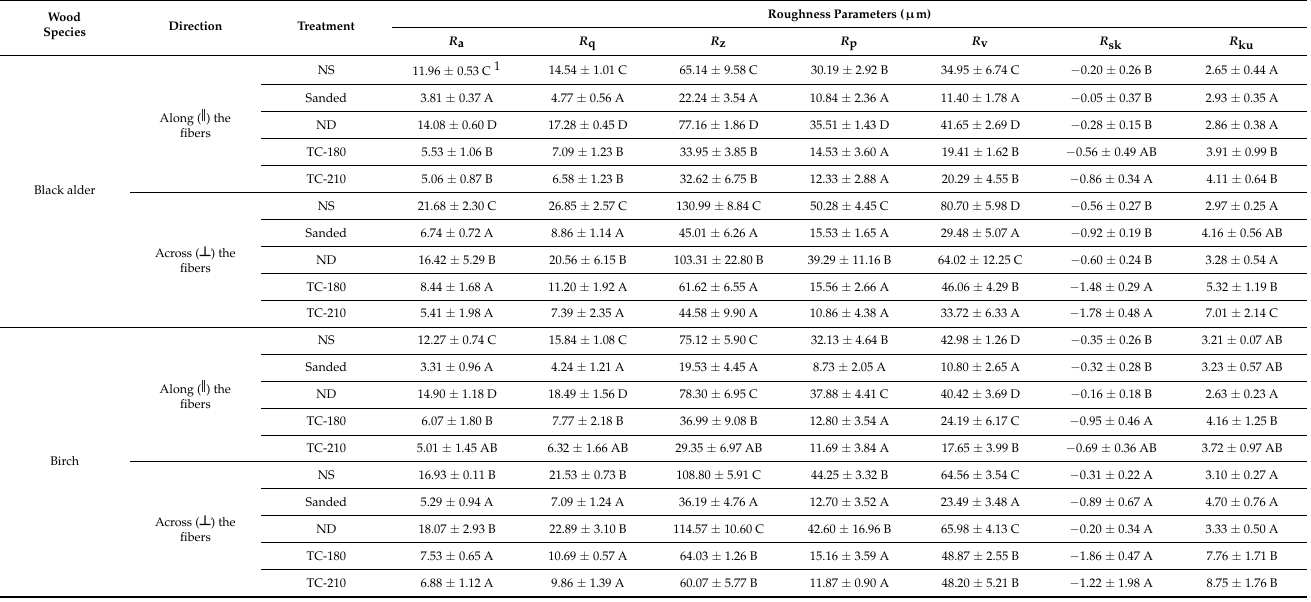
Table 2. Average roughness values of the non-treated and pre-treated samples.